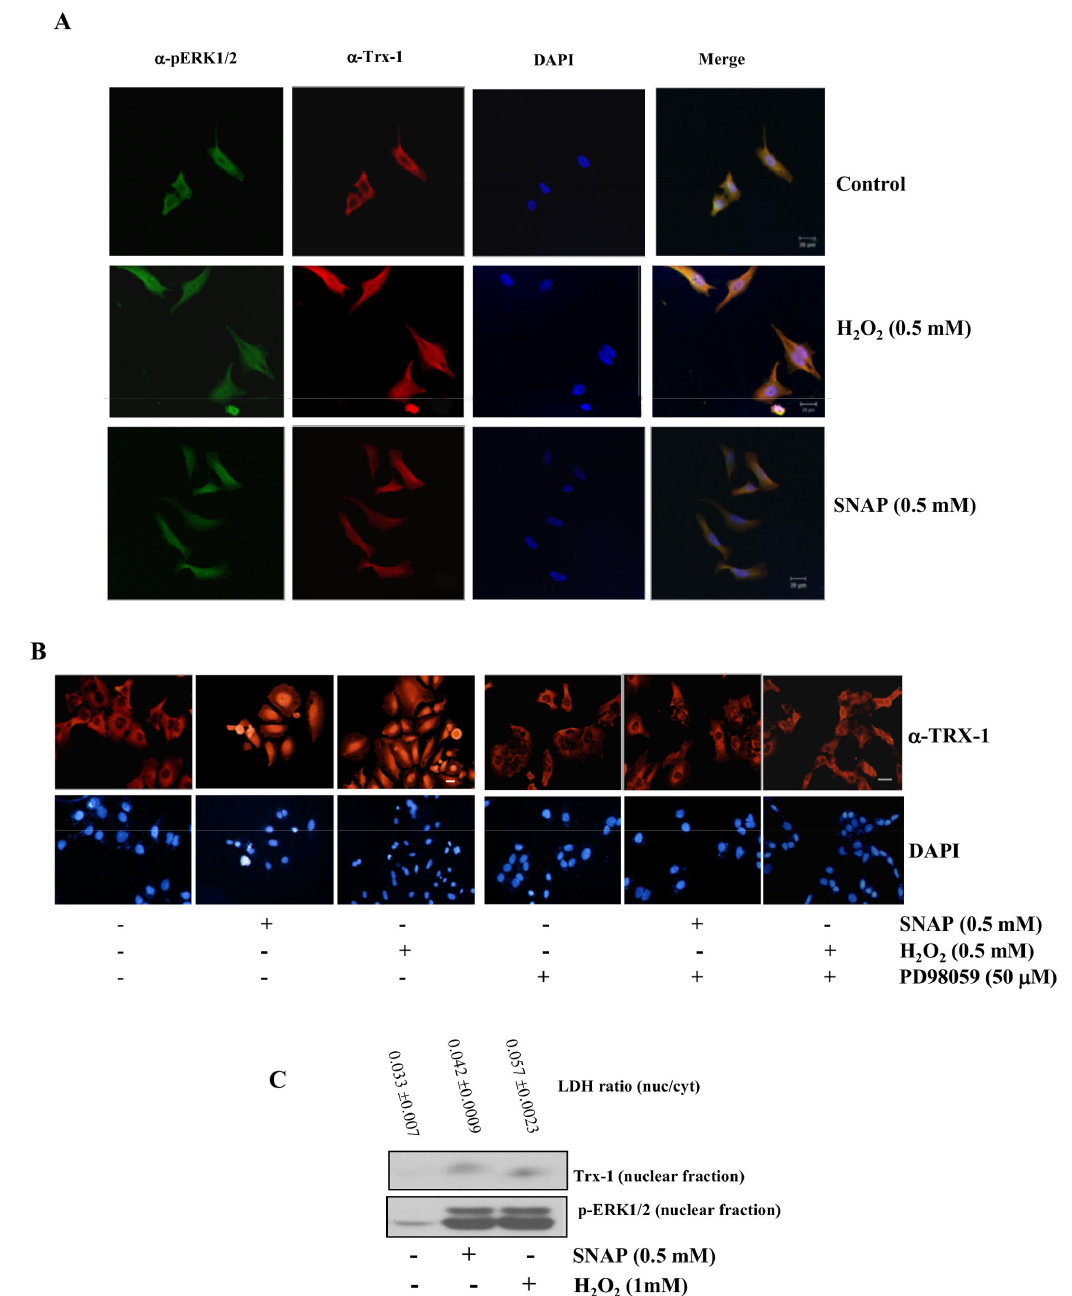
Figure 2. Confocal microscopy and western blot analysis to determine TRX-1 and phospho ERK 1/2 MAP Kinases sub- cellular location in wild-type HeLa cells. ( A ) Cells were treated with SNAP (0.5 mM), or H O (0.5 mM) for 2 h at 37°C. Detection 2 2 of TRX-1 and phospho-ERK 1/2 MAP Kinases was performed as described in Materials and Methods. Bar = 20µm. ( B ) Cells were treated with SNAP (0.5mM) or H O (0.5 mM) for 2 h at 37°C. HeLa cells were pre-treated with 50μM PD98059, a MEK inhibitor, for 2 2 30 min and incubated with 0.5mM SNAP or 0.5 mM H O for 2 h at 37°C. Detection of TRX-1 was performed on a fluorescence 2 2 microscope as described in Materials and Methods. Images shown are representative from three independent experiments. Bar = 20µm. ( C ) HeLa cells were incubated with SNAP and H O at the indicated concentrations for 2 h and nuclear extracts were 2 2 subjected to Western blotting with the anti-human TRX-1 mouse monoclonal antibody and with the anti-human phospho-ERK1/2 MAP Kinases rabbit polyclonal antibody. Western blot results are representative of three independent experiments. Purity of nuclear fractions was estimated by LDH detection as described in Materials and Methods. Values are means ± S.D. of triplicate cultures. doi: 10.1371/journal.pone.0084588.g002 PLOS ONE |